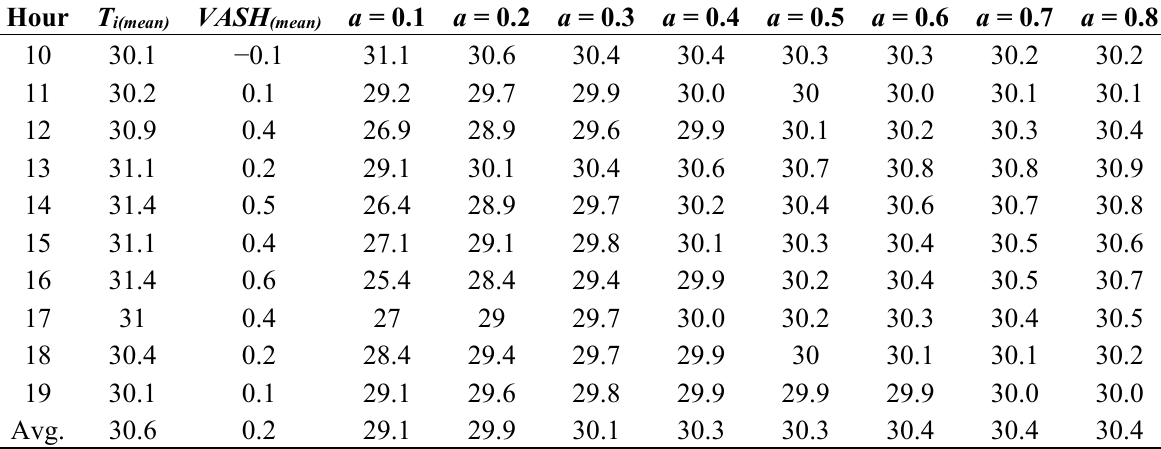
Table 5. Mean hourly comfort temperature according to the Griffiths